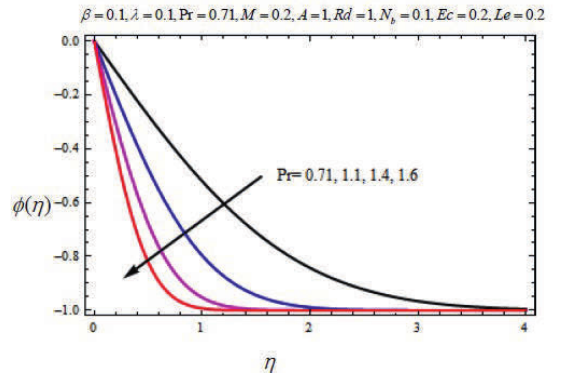
Fig. 20: Variation of nanoparticle concentration with η for several values of Prandtl number Pr .